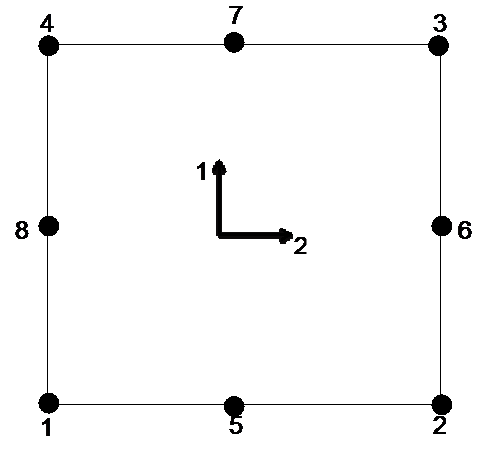
Figure 3: The DKQ